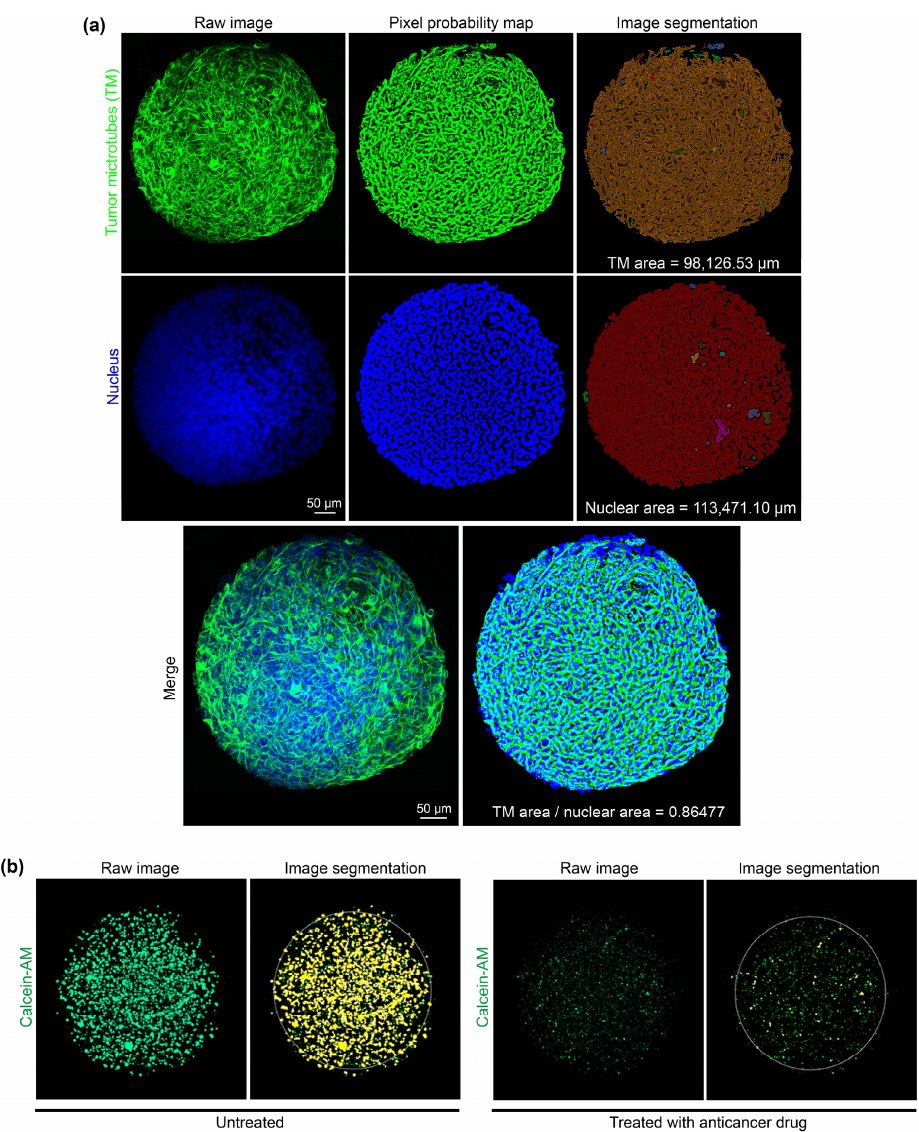
Figure 3. Automated computational analysis of TM network density and cell viability in PD-GBOs. ( a ) Quantification of the TM-connected tumor network used nestin (top left image, green), which is highly expressed in network-integrated glioma cells. The areas of the nuclei (blue Hoechst stain, middle-left images) and tumor network (nestin) were converted to pixels (top- and middle-center image) and then segmented (top- and middle-right images). The quotient of nestin area by nuclear area provides an index for tumor network density. ( b ) Quantification of cell viability used the cell viability dye, calcein-AM (left image). Shown are representative images of PD-GBOs from patient MA01. The untreated control PD-GBO (left images) has significantly more viable cells compared to the PD-GBO after afatinib treatment (30 µ M; right